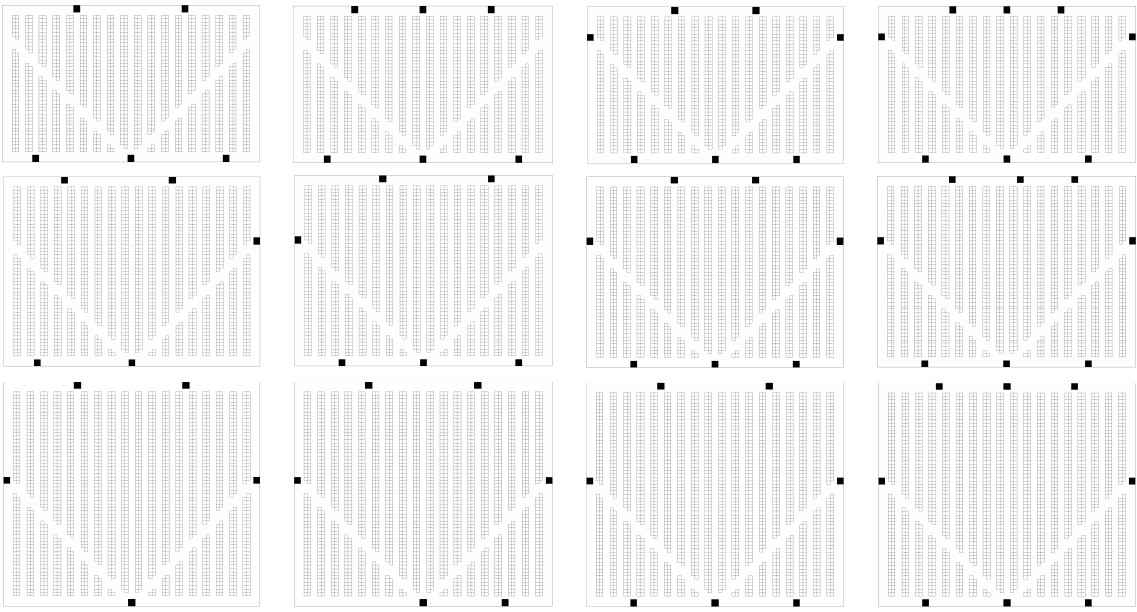
Figure A3. Optimal workstation layout in flying-V warehouses ( N = 36; L = 40,50,60; K =